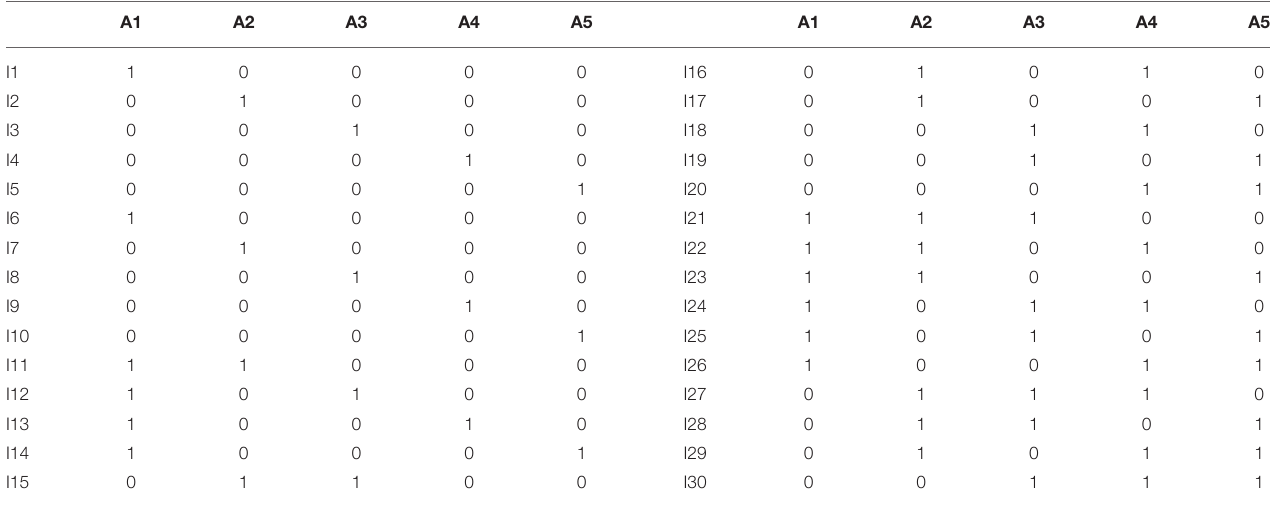
TABLE 1 | The Q-Matrix of the simulation